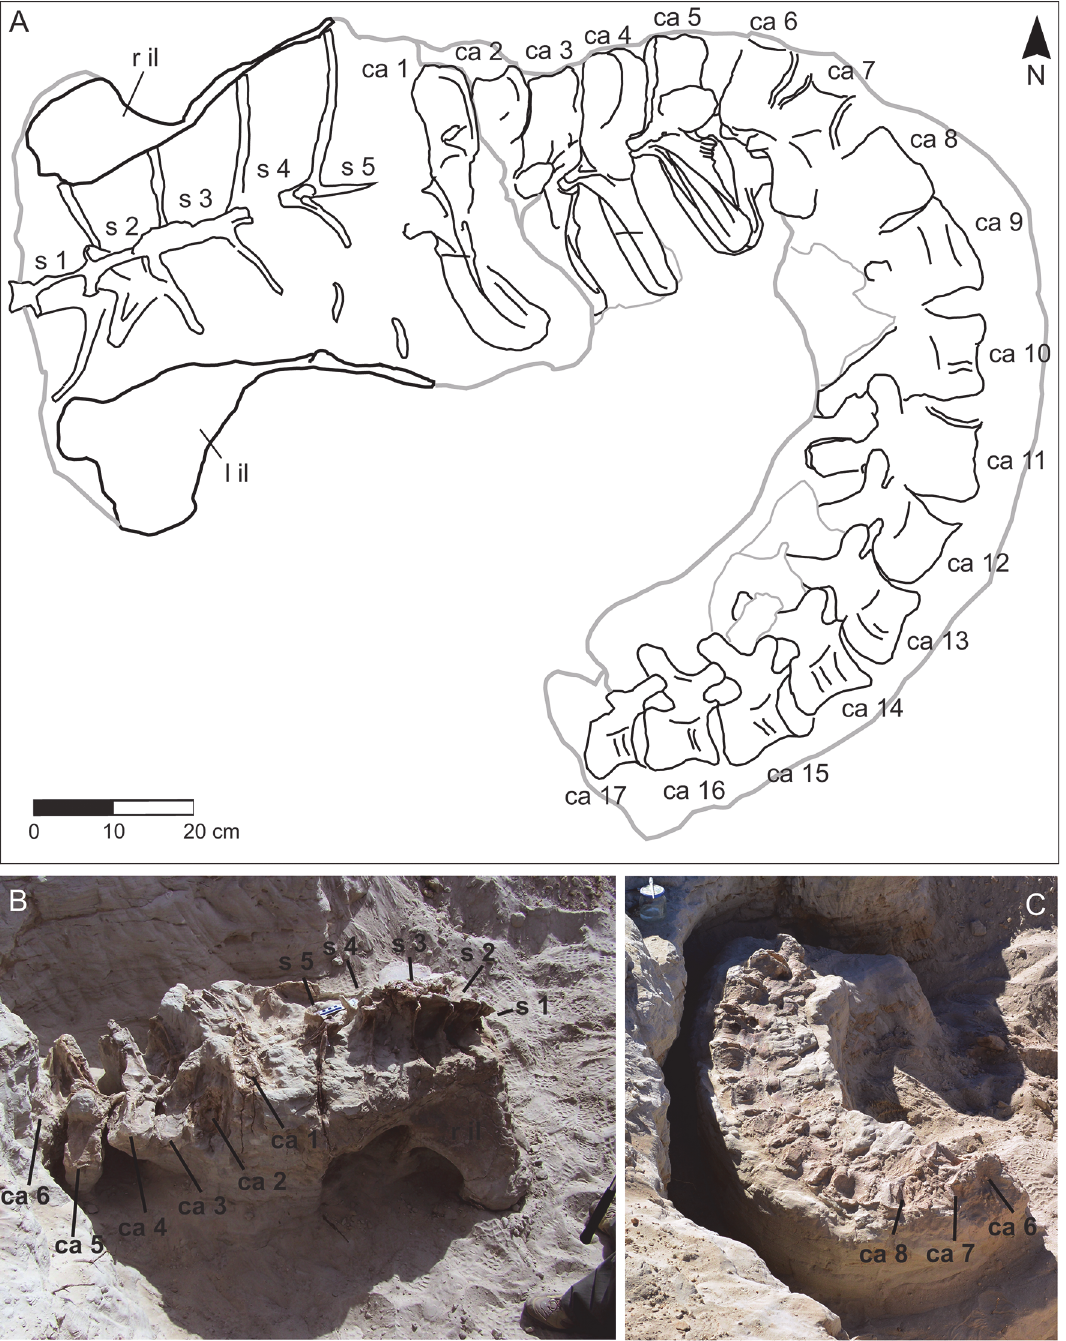
Fig 3. Preserved elements of Tataouinea hannibalis (ONM DT 1 – 48). A, quarry map showing the orientation of collected elements. B, field photograph of the elements collected at the end of 2011, and C, of elements collected in 2013. Ca, caudal vertebra 1 – 17; S, sacral vertebra 1 – 5; r il, right ilium; l il, left ilium.